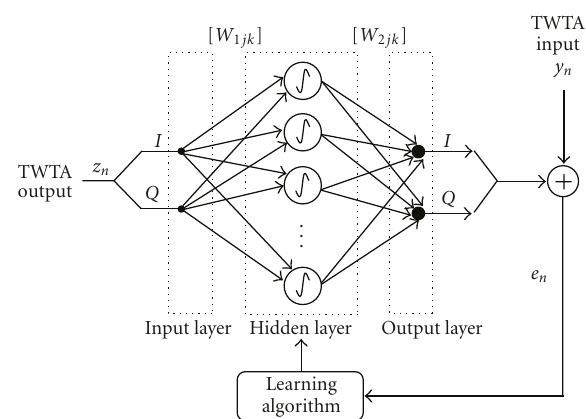
Figure 11: A multilayer neural network. The network has two layers, two input signals, one hidden layer, 2 neurons in the output layer, and 2 output signals. (Indexes I and Q refer to the real and imaginary parts, resp.)